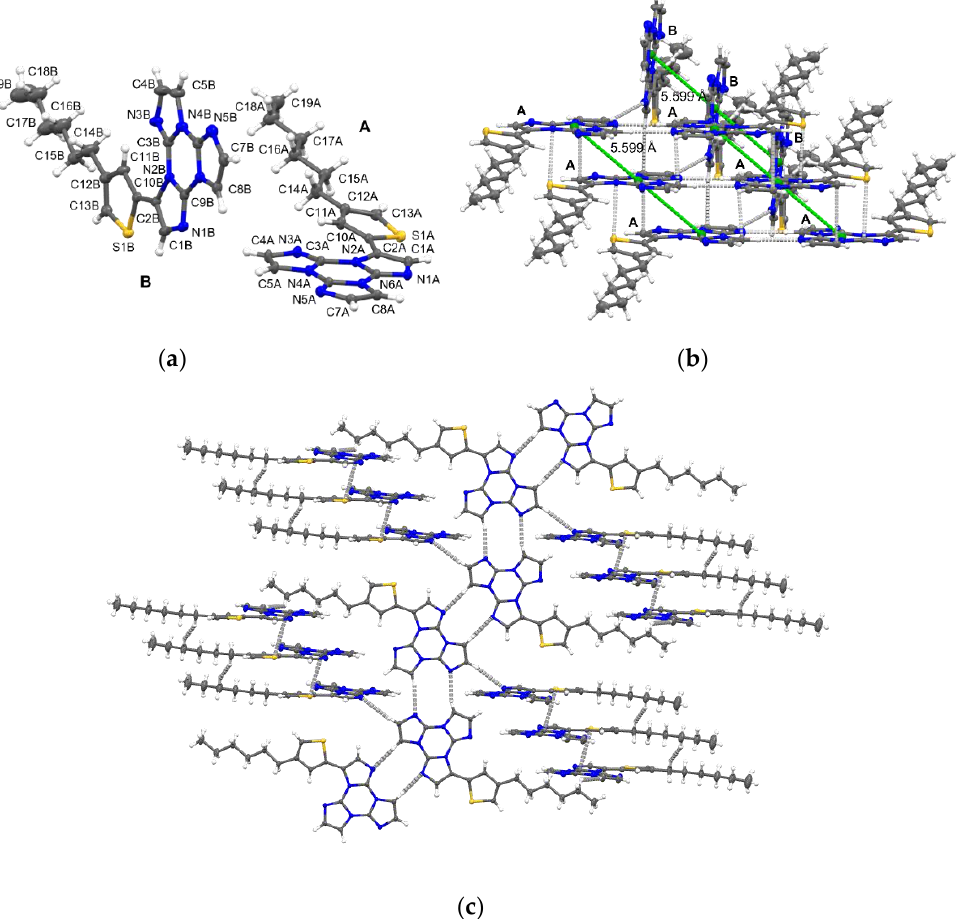
Figure 7. Ortep plots of TT-HThio showing: ( a ) the two molecules (A and B) of the asymmetric unit; ( b ) a fragment of crystal packing with shorter distances between triazinic geometrical centroids (green spheres) and C ⋯ C, C ⋯ S and C – H ⋯ π intermolecular contacts shorter than the sum of vdW radii (light grey – dashed lines); ( c ) the hydrogen bonded ribbon formed by A molecules and the π -stacks of B molecules. Ellipsoids at 20%